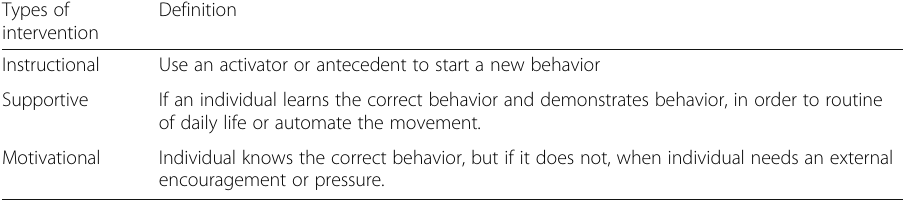
Table 1 Types of Intervention and their definition (Geller,